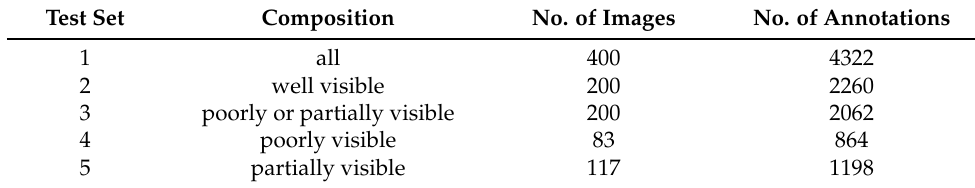
Table 2. Statistics of the used test sets.